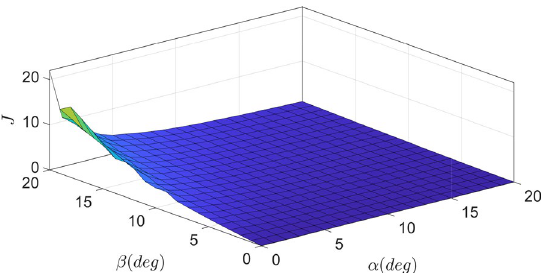
Fig. 14 Cost function values of NPL shape